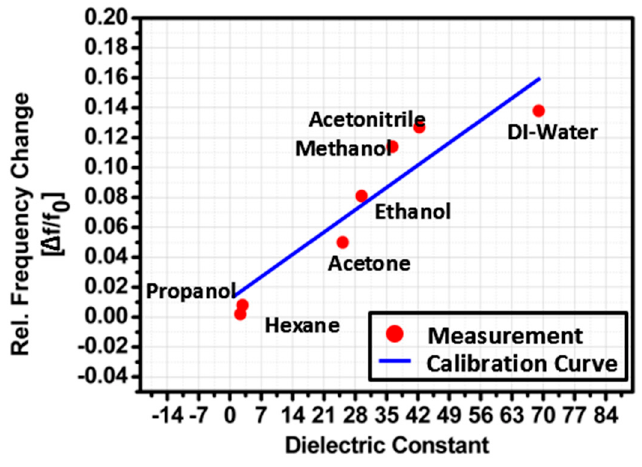
Figure 9. Sensitivity of the proposed SIW chemical sensor.